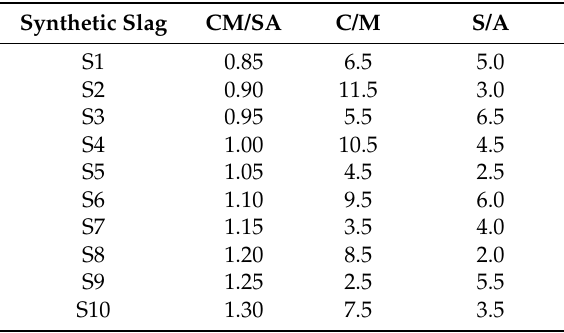
Table 2. The designed chemical compositions of ten slags by uniform design method.